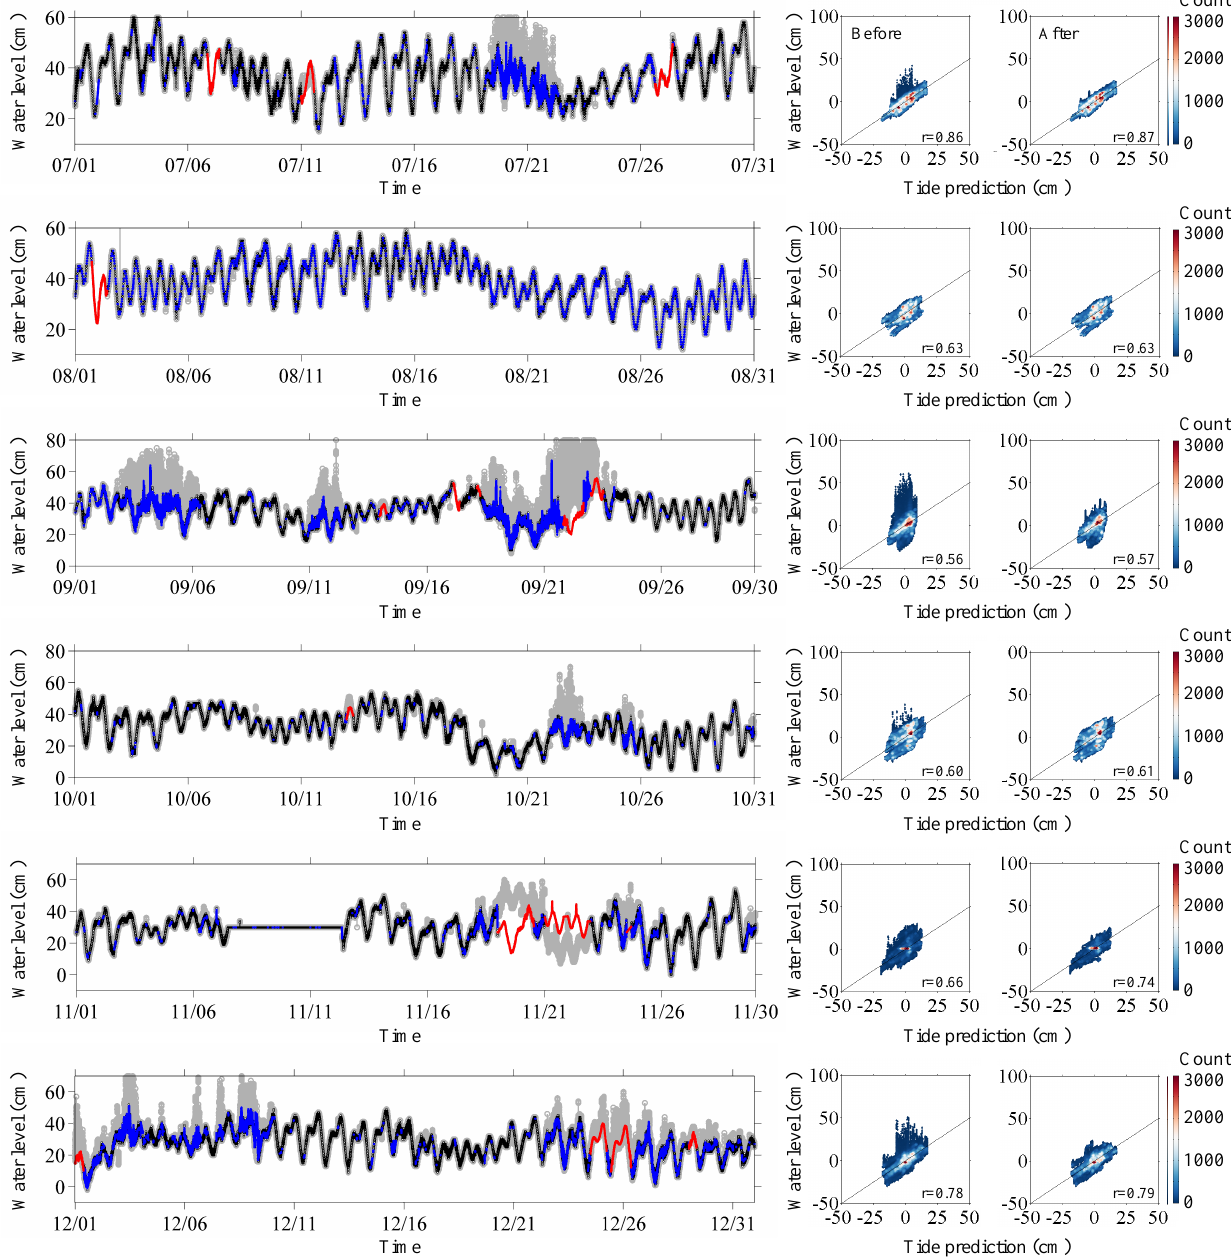
Figure 12. Performance test of the outlier removal and gap-filling algorithms. Left panels: time series of the Ulleung-do surge gauge after applying both outlier removal and gap-filling algorithms (black line). Outliers are marked by a gray line and gap-filled data are marked by a blue line (SGFA) and a red line (LGFA). The yellow box in March indicates the event period. Scatter plots show the comparison between before and after applying both outlier removal and gap-filling algorithms (middle and right). The mean value of each axis in the scatter plot is fixed to zero by subtracting the mean value of each datum from its data. The color point represents the frequency of data plotted inside the circle with a radius of 1cm. The right corner represents the correlation